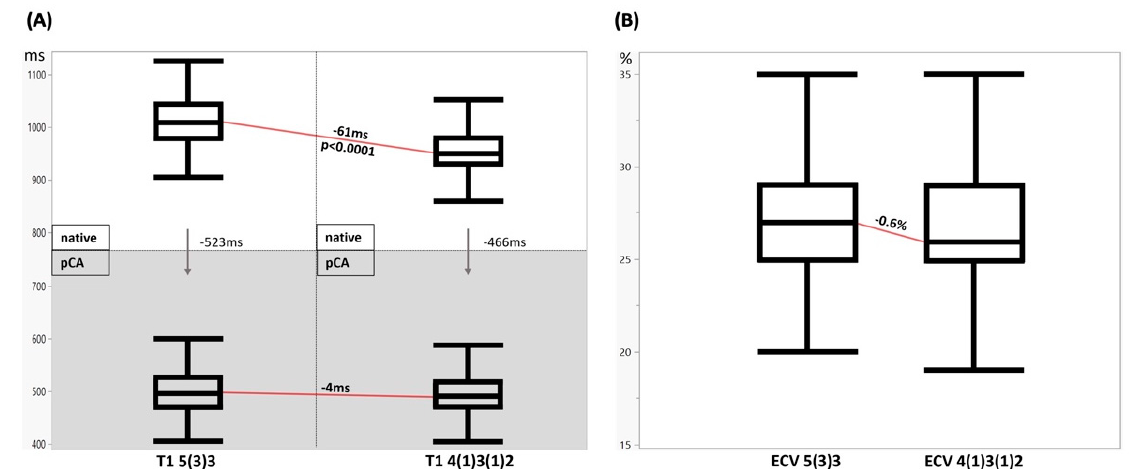
Figure 3. In vivo T1 mapping and ECV calculation results. ( A ) Myocardial T1 native vs. post-contrast agent 5(3)3 vs. 4(1)3(1)2. Myocardial T1 native (top row) vs. post-contrast agent (bottom row, grey) for both MOLLI sequence types, 5(3)3 (left) vs. 4(1)3(1)2 (right). The arrows visualize the signal drop caused by contrast agent application. The red lines show the systematic underestimation of native myocardial T1 and almost no intraindividual difference post-contrast in 4(1)3(1)2 MOLLI. ( B ) Myocardial ECV 5(3)3 vs. 4(1)3(1)2. ECV calculation is similar with both methods. Myocardial ECV estimation was systematically slightly lower for 4(1)3(1)2